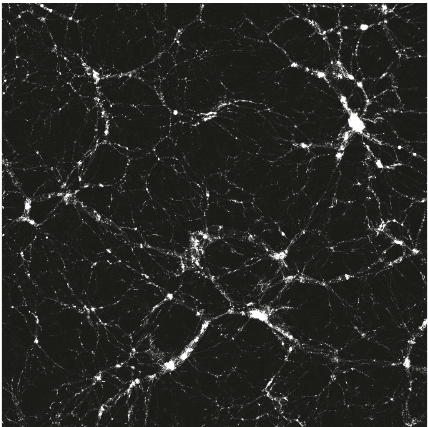
Figure 4: Slice of 125 ℎ −1 Mpc side length of the cosmic web structure formed in the Bolshoi cosmological 𝑁 -body